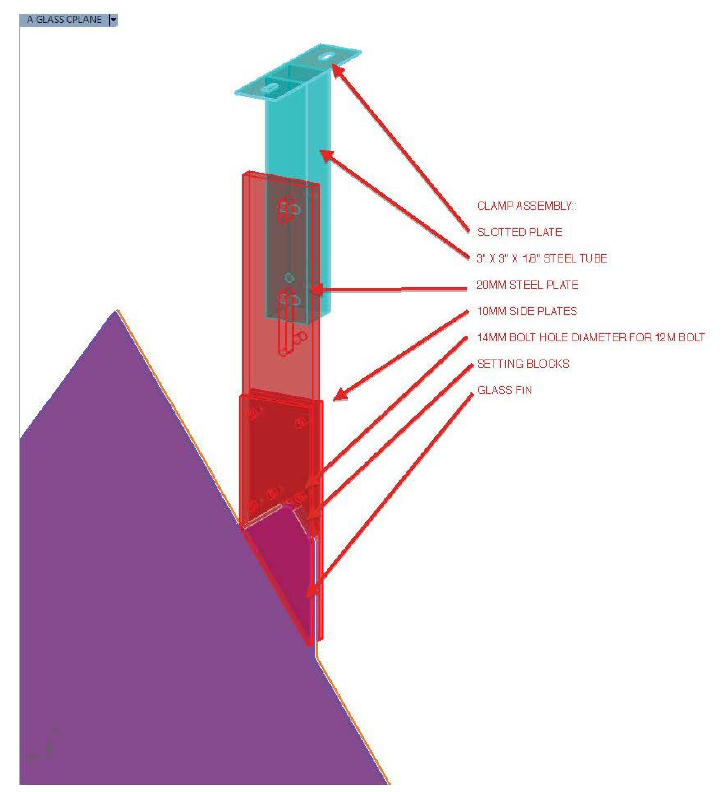
Fig. 20 33-D, 2014 | Upper clamp support Rendering courtesy of Sarah Oppenheimer